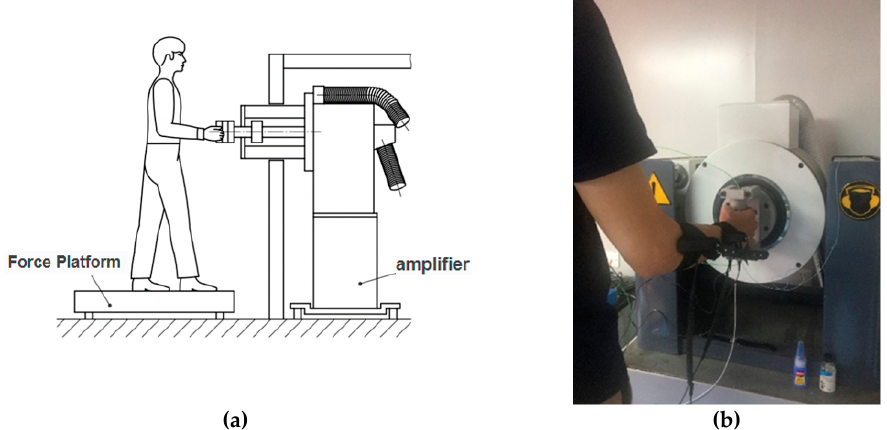
Figure 3. Vibration excitation system with instrumented handle. ( a ) Position of subject on force platform; ( b ) identification of the measuring points on the wrist and elbow.